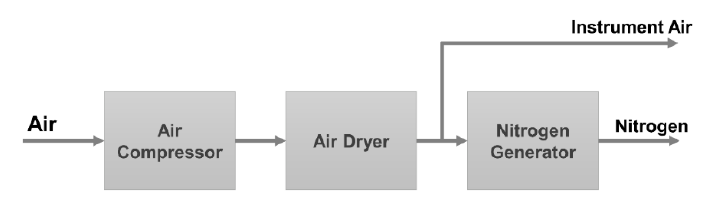
Figure 2. Block diagram of air and nitrogen systems.